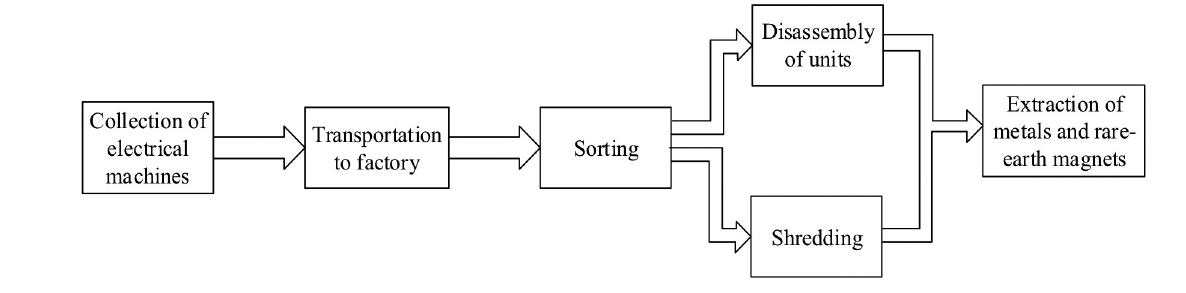
Fig. 6. Evaluation of electrical machines recycling for end­of­life products extraction